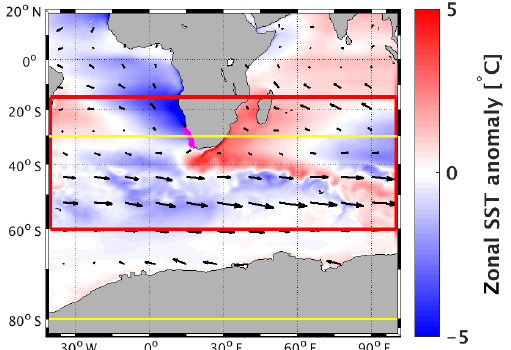
Figure 1. Figure of the research area. Shaded colors (deviations of sea surface temperature from their zonal mean of the INALT20 sim- ulation) depict the warm Agulhas Current at the southeast coast of South Africa and the cool Benguela current at the southwest coast. Arrows show the mean wind stress field in the study region, de- rived from the COREv2 data set. The area between 40 ◦ W–100 ◦ E and 15–60 ◦ S, in which the position and intensity of the trade winds and westerlies are calculated, is indicated by the red box. The yel- low lines represent the northern and southern border (30 and 80 ◦ S) where the Southern Hemisphere temperature gradient is calculated. The magenta line is the area where the upwelling index for South Benguela is taken (27–34 ◦ S, 100km offshore to